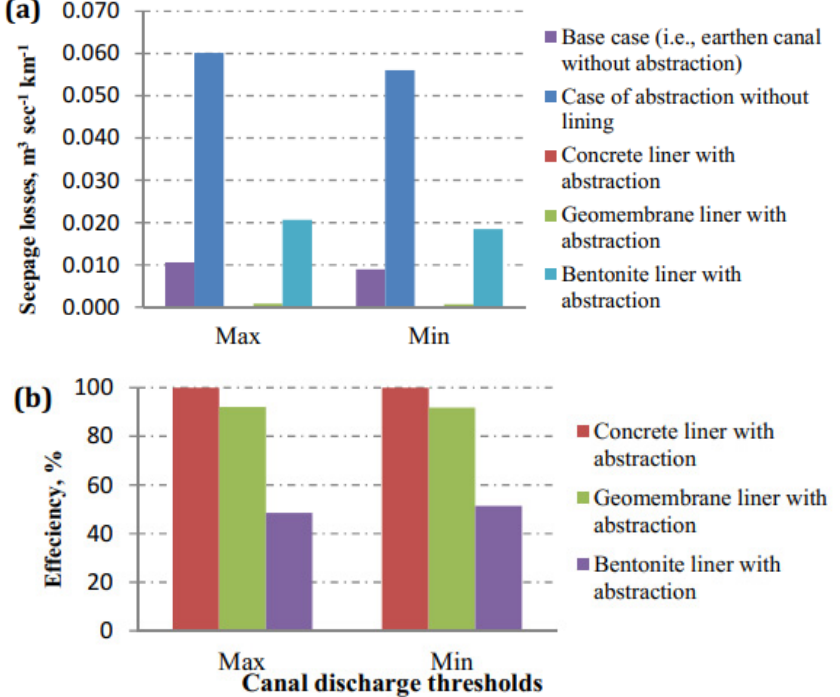
Figure 8. Canal linings of different materials with extraction for ( a ) seepage losses and ( b ) efficiency.